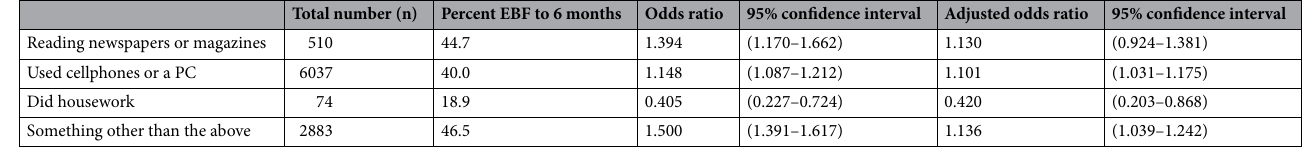
Table 3. Personal factors influencing EBF rates until 6 months postpartum in Japan. Data acquisition. a During early pregnancy/ b during mid-pregnancy/ c 1 month postpartum/ d 6 months postpartum/ e attending physician diagnosed just after delivery.